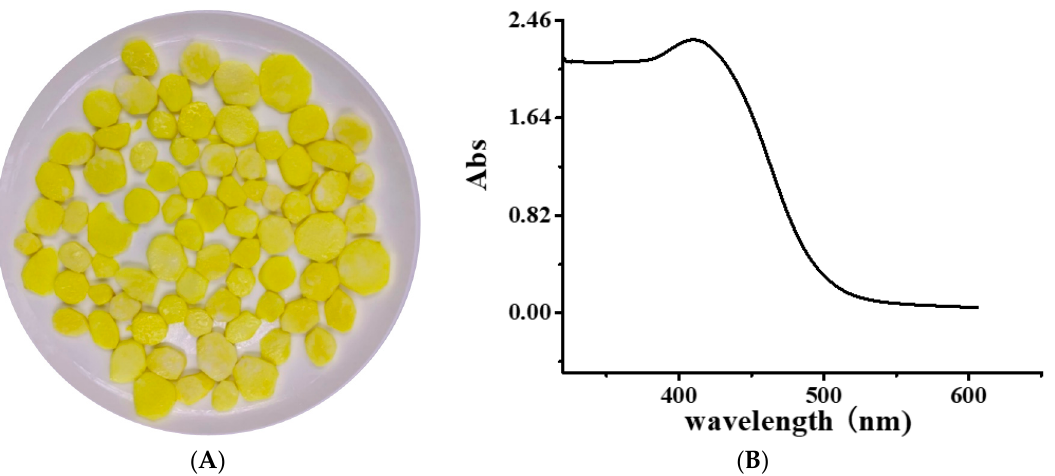
Figure 1. ( A ) Image of yellow freshly cut yam and ( B ) Ultraviolet-Visible (UV–Vis) spectrum of yellow pigment (YP).